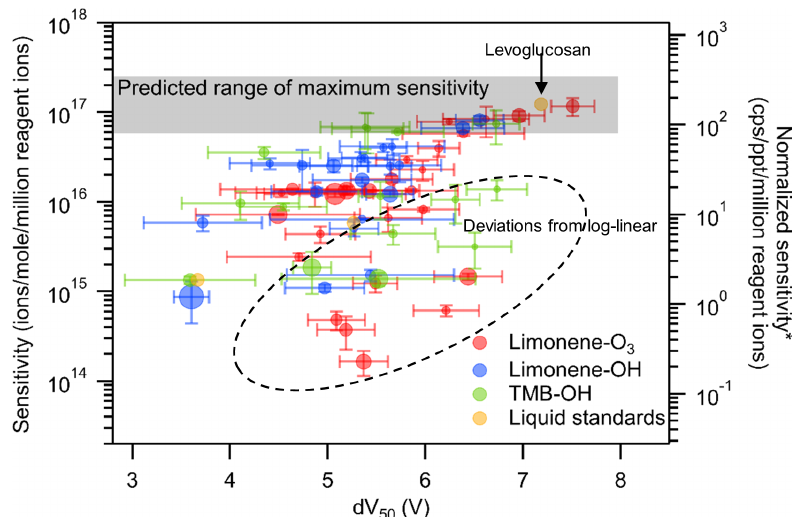
Figure 4. Relationship between sensitivities and d V 50 of compounds identified in oxidation experiments as well as liquid standards. Each data point is a compound identified with the marker area representing the moles of the compound. The error bars on the y axis are the standard deviation of sensitivity in triplicate (limonene-O 3 ) or three different OH level measurements (limonene-OH and TMB-OH). The error bars on the x axis are the standard deviation of d V 50 in duplicate measurements. ∗ : unit converted for direct-air-sampling CIMS using 100mbar in IMR, 2slpm sample flow rate, and 2slpm reagent ion flow rate.